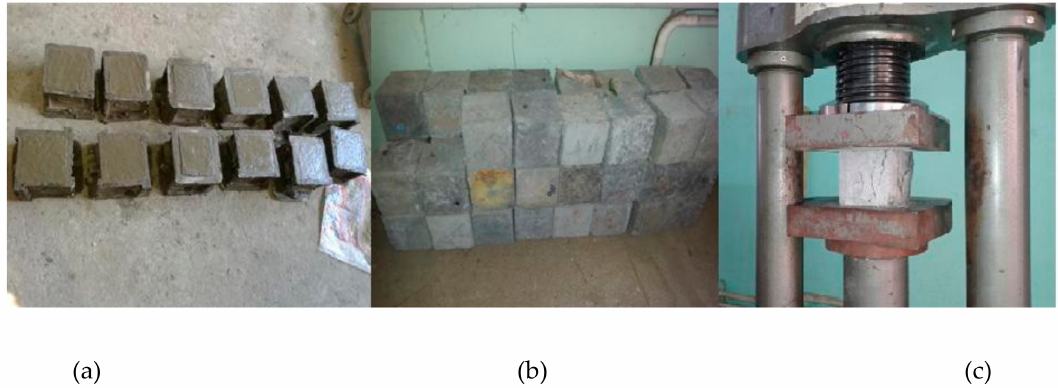
Figure 11. ( a ) Casting, ( b ) curing and ( c ) testing of mortar cubes.